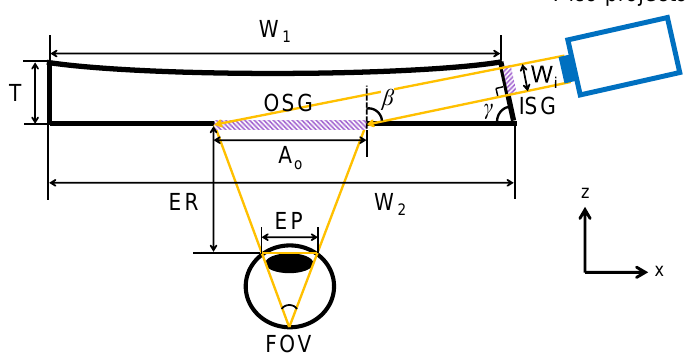
Figure 7. Illustration of the horizontal expansion of the exit pupil by the out-coupling slanted grating (OSG). β is the angle of beam incident to OSG, γ the bevel angle, W i the width of the ISG, A o the horizontal length of elongated exit pupil.